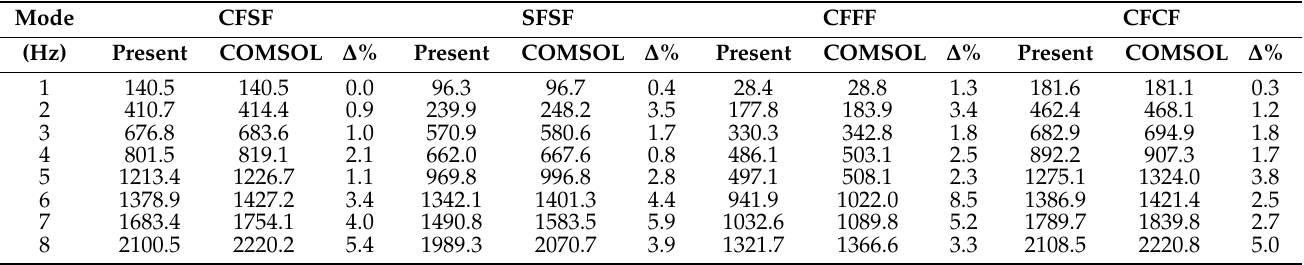
Table 3. Comparison of the first six natural frequencies of the plate under different boundary conditions.